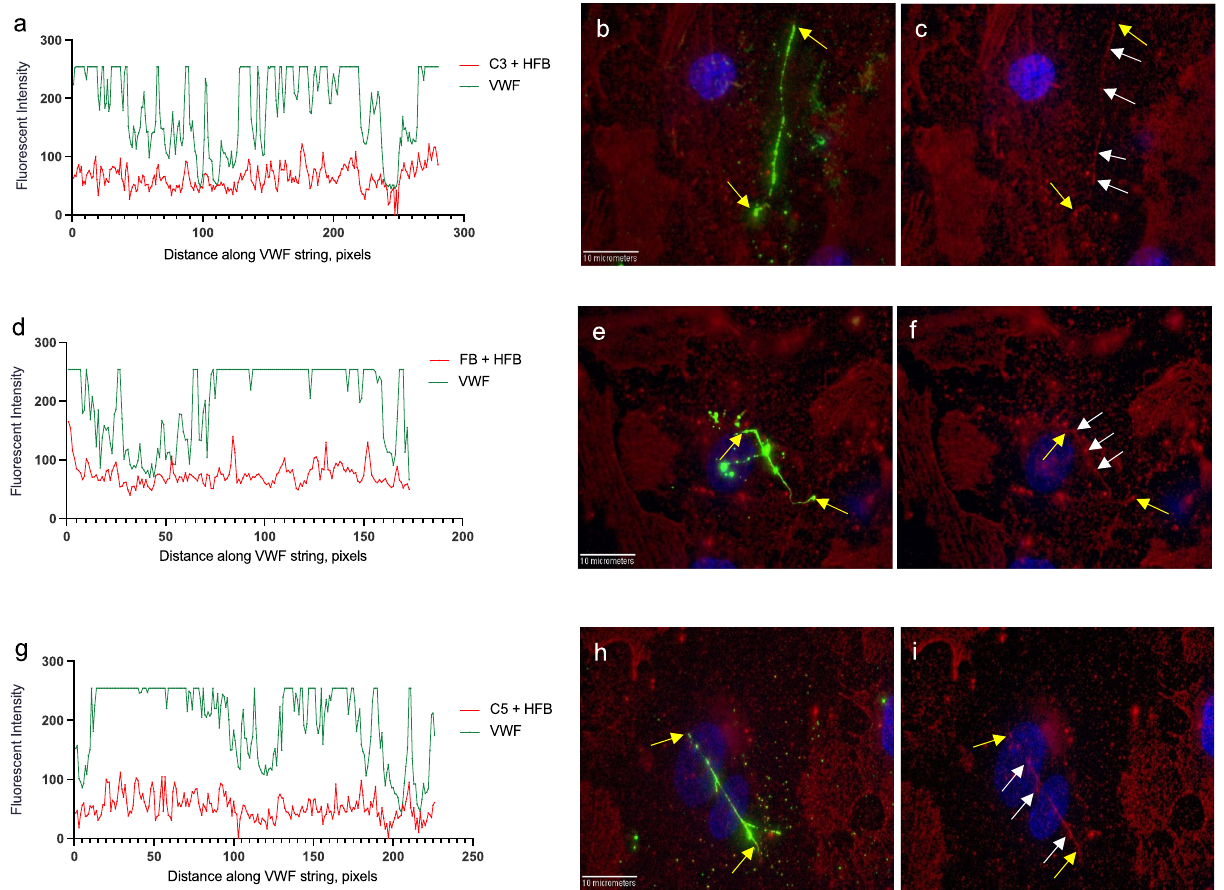
Figure 5. C3, FB and C5, even in the presence of HFB, bind to GMVEC-secreted ULVWF strings. GMVECs were stimulated with 100 µM histamine containing 20 µg/ml HFB for 2 min, followed by addition of rabbit anti-VWF + chicken anti-rabbit AF-488 (green) for 15 min (also in the presence of HFB). Cells were then p-formaldehyde-fixed and stained with: goat anti-C3 ( a–c ); goat anti-FB ( d–f ); or goat anti-C5 ( g–i ); and secondary donkey anti-goat IgG AF-647 (red). Cell nuclei were detected with DAPI (blue). Graphs show the fluorescent intensities (y-axis) measured along the ULVWF string (x-axis, length in pixels, 1 pixel = 0.114 µm) from merged images of detected VWF with detected C3, FB, or C5 (with HFB present during incubation). The yellow arrows in the merged images indicate the start and end points of the strings. The white arrows in the merged images of complement proteins (647 nm, red) with DAPI detection indicate high 647-intensity values (in order to assist visualization of the measured line). Images were obtained at 60X and were selected from over 130